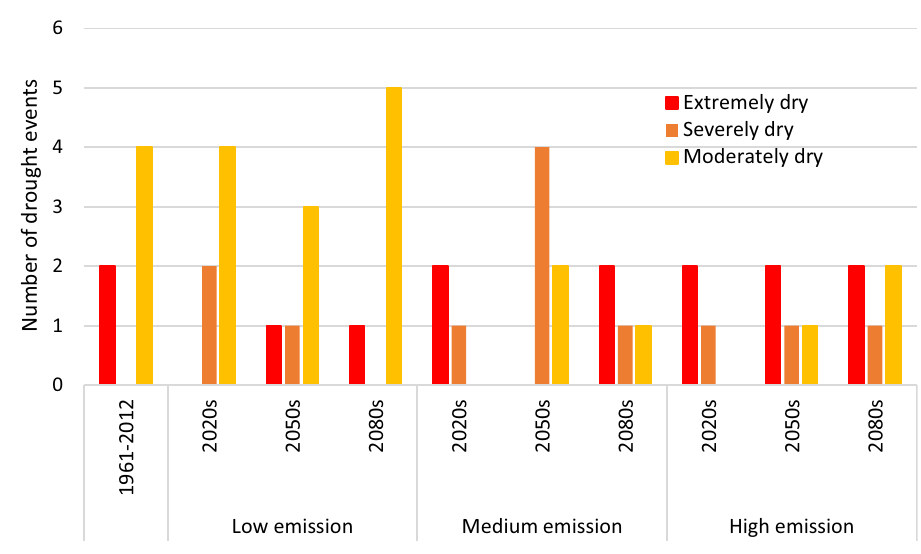
Fig. 12 Comparison of different drought events for the historic (1961–2012) and for the future (2020s, 2010–2039), (2050s, 2040–2069), (2080s, 2070– 2099) under low, medium and high emission